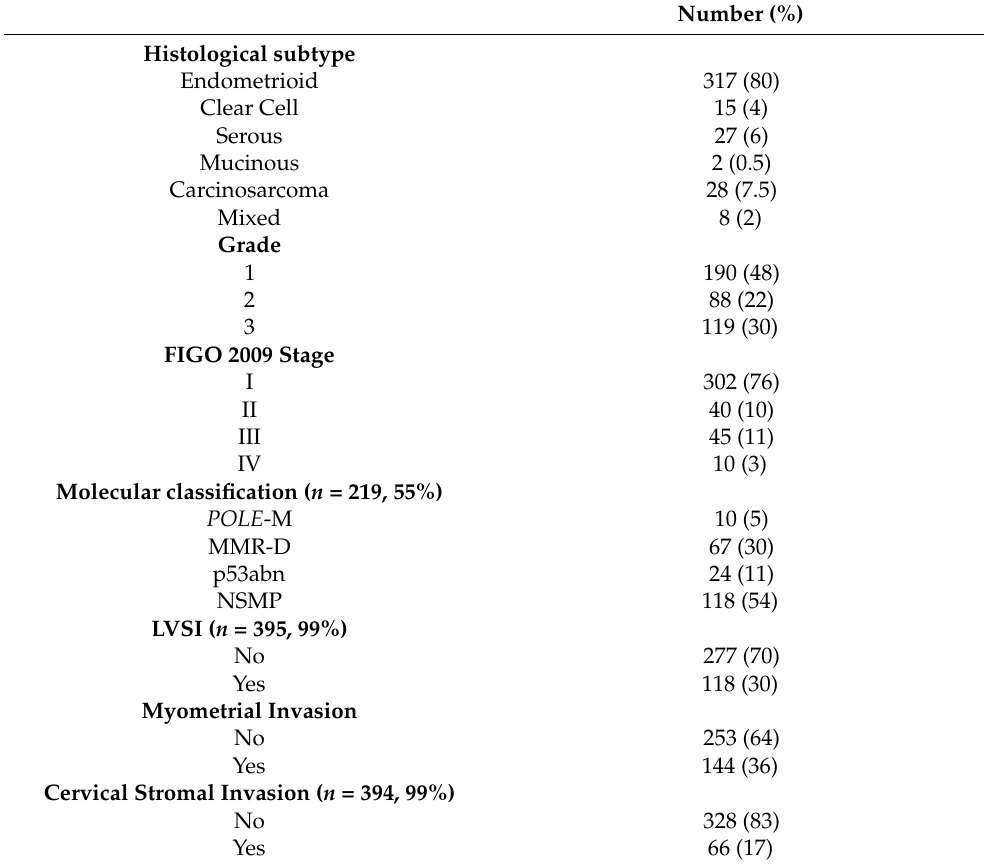
Table 2. Pathological characteristics of endometrial cancers n =